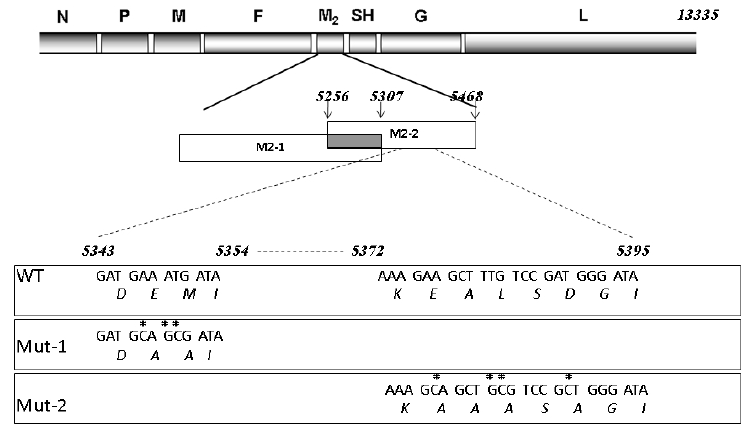
Figure 1. Map of human metapneumovirus (hMPV) antigenome and the mutations introduced to generate the M2-2 mutants. The overlapped open reading frame of M2-1 and M2-2 are shown as a gray rectangle with oligonucleotide sites given above. M2-2 amino acids labeled with stars were mutated to alanine to abolish interested PDZ binding